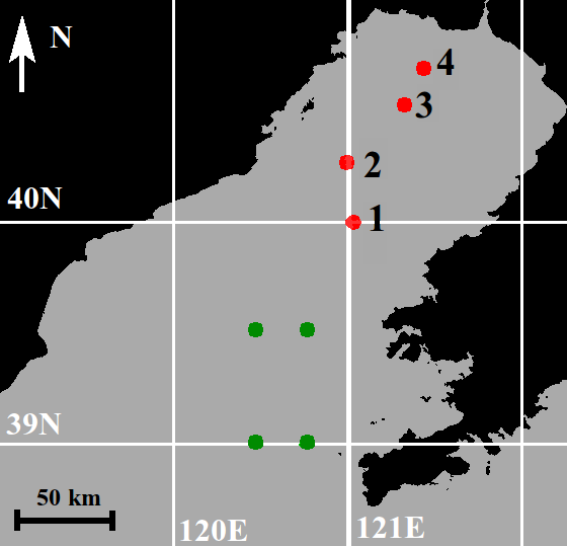
Figure 4. Locations of the oil platforms where the in-situ measurements were conducted. The oil platforms are indicated by the red dots, and additionally, four reference points of open-water, indicated by green dots, were used in the study.